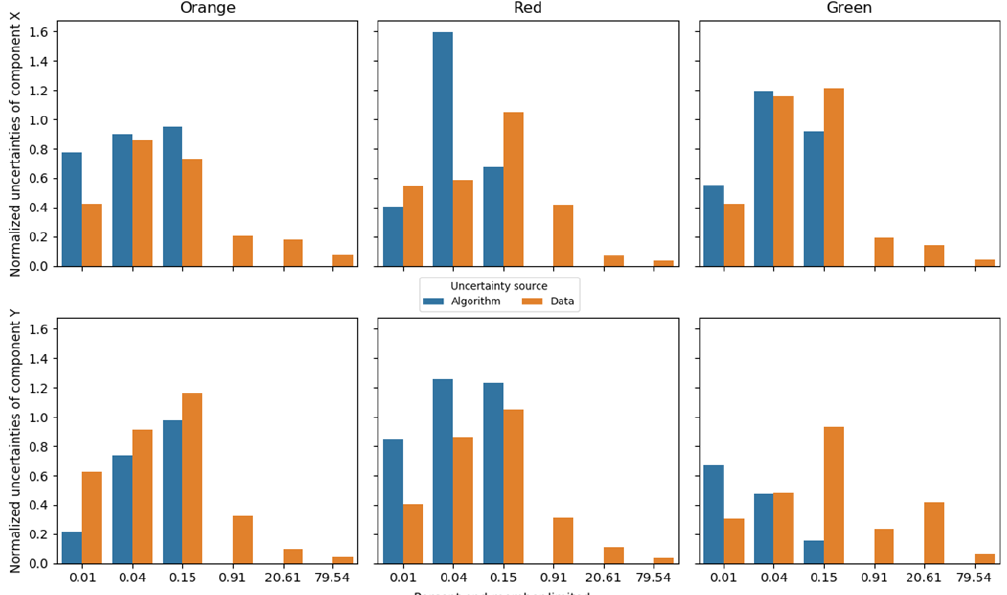
Figure 9. Standard deviation of the predicted end-members, with sources separated into algorithm and data groups using the synthetic data. Component X and Y represent the two synthetic measures, X [–] and Y [–], in Fig. 8. The X -axis percent end-member-limited values are corresponding to the synthetic case numbers in Fig. 8. A percent end-member-limited value is a measure of the degree to which the synthetic data were constrained by the mixing space (it is the proportion of randomly generated normally distributed samples that fell outside of the triangular constraint of the end-members and which were discarded). In each case, samples were continuously generated from the normal distribution with the given variance until 1000 samples fell within the triangular